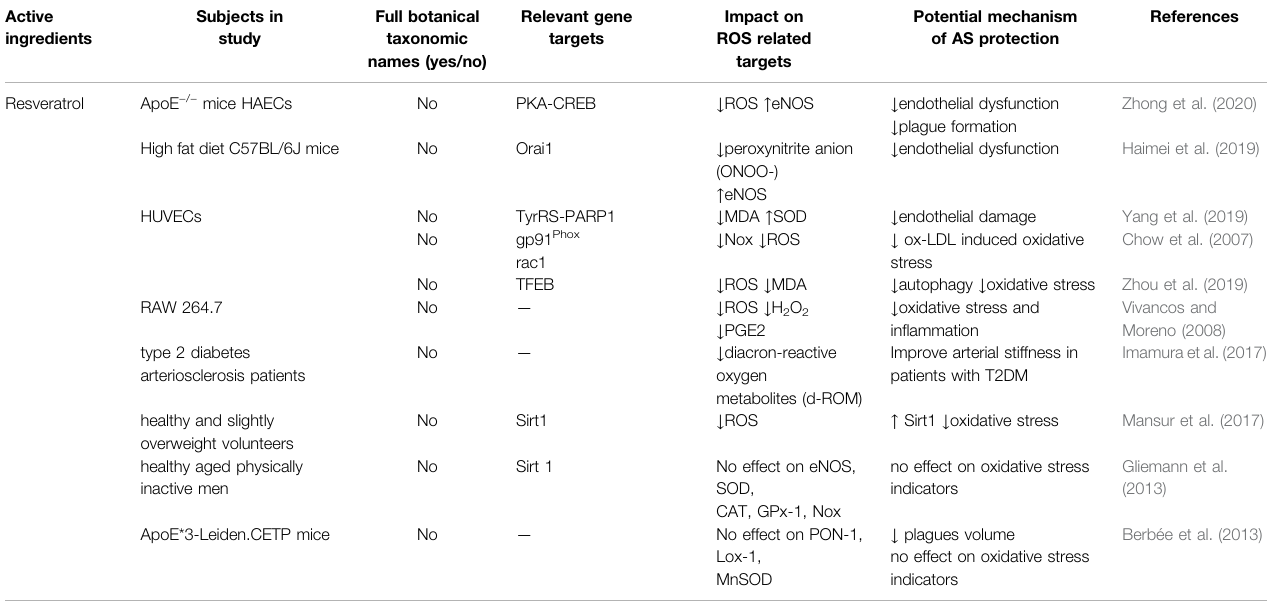
TABLE 1 | Resveratrol for treatment of atherosclerosis by regulating oxidative stress. Active